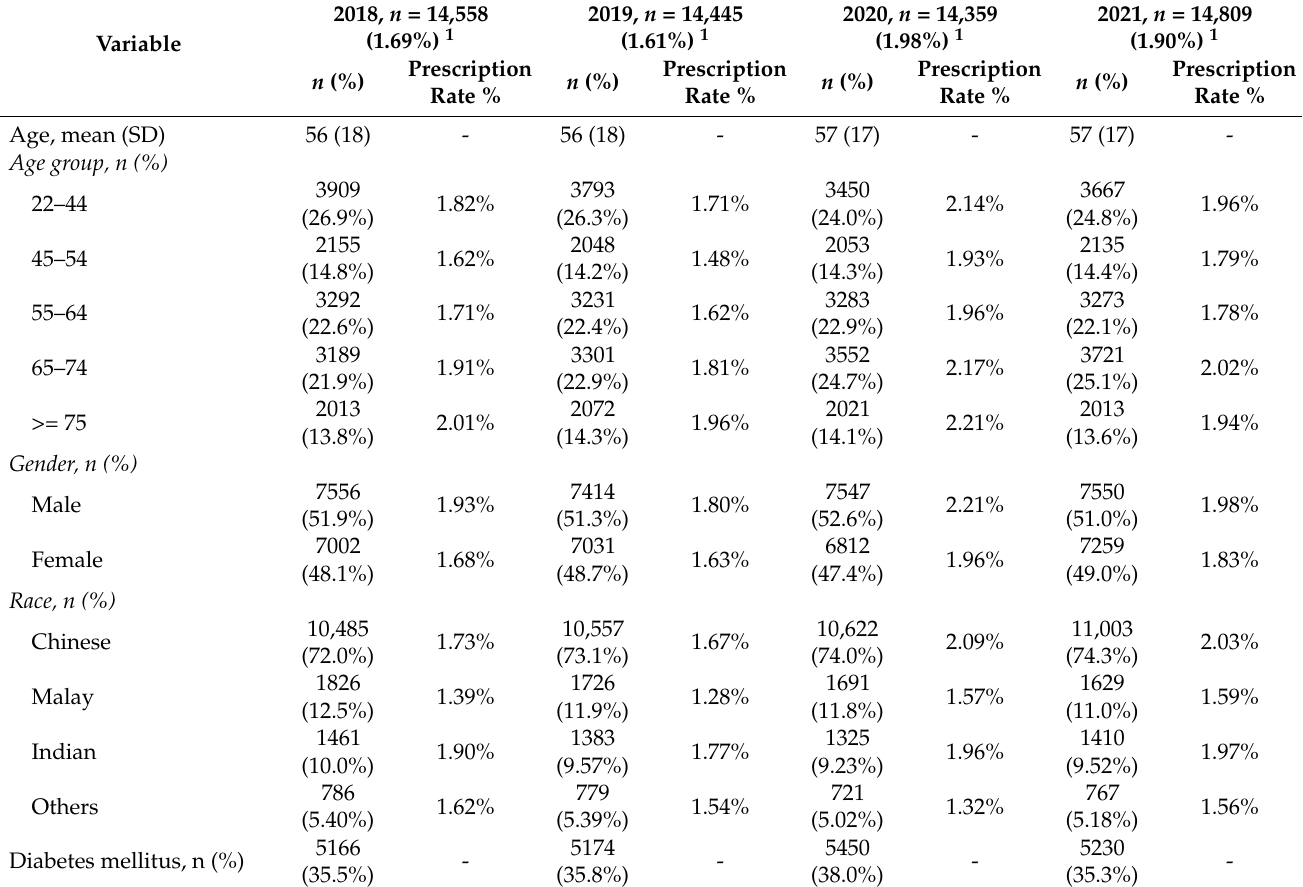
Table 5. Topical skin antibiotic prescriptions,